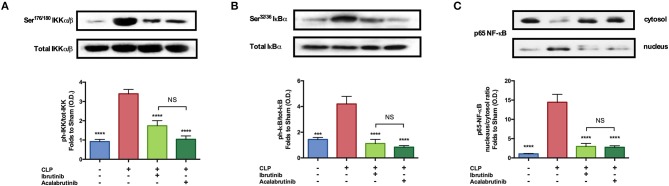
Cardiac NF-κB activation in CLP mice is reduced by ibrutinib or acalabrutinib. Mice were randomly assigned to undergo CLP or sham surgery. One hour later, mice were treated with ibrutinib (30 mg/kg i.v.), acalabrutinib (3 mg/kg i.v.), or vehicle (5% DMSO + 30% cyclodextrin i.v.). At 24 h cardiac tissue was collected and signaling was assessed (n = 5 per group). Densitometric analysis of the bands is expressed as relative OD of (A) phosphorylation of IKKα/β at Ser176/180 corrected for the corresponding total IKKα/β and normalized using the related sham band. (B) Phosphorylation of IκBα at Ser32/36 corrected for the corresponding total IκBα and normalized using the related sham band. (C) NF-κB p65 in both nucleus and cytosol and expressed as a ratio, normalized using the sham related bands. All data are expressed as mean ± SEM for n number of observations. A value of ****P < 0.0001 was considered to be statistically significant when compared to the control by one-way ANOVA followed by a Bonferroni's post-hoc test.